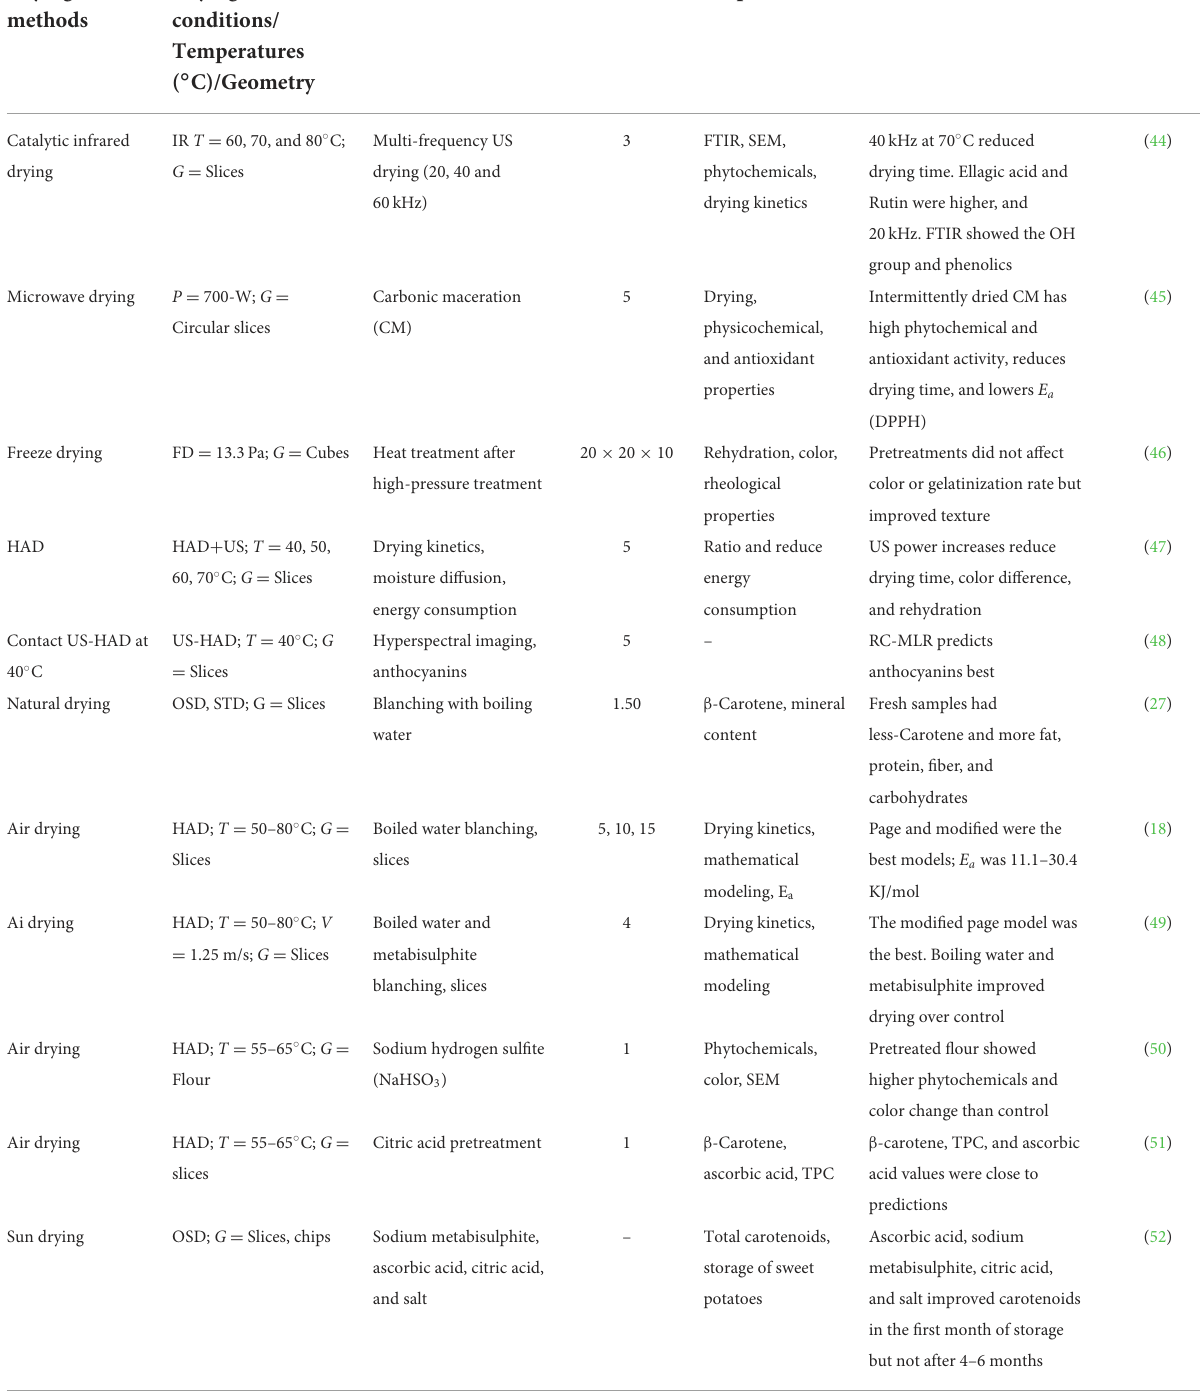
TABLE 3 Application of different pretreatments along with varying methods of drying on drying of sweet